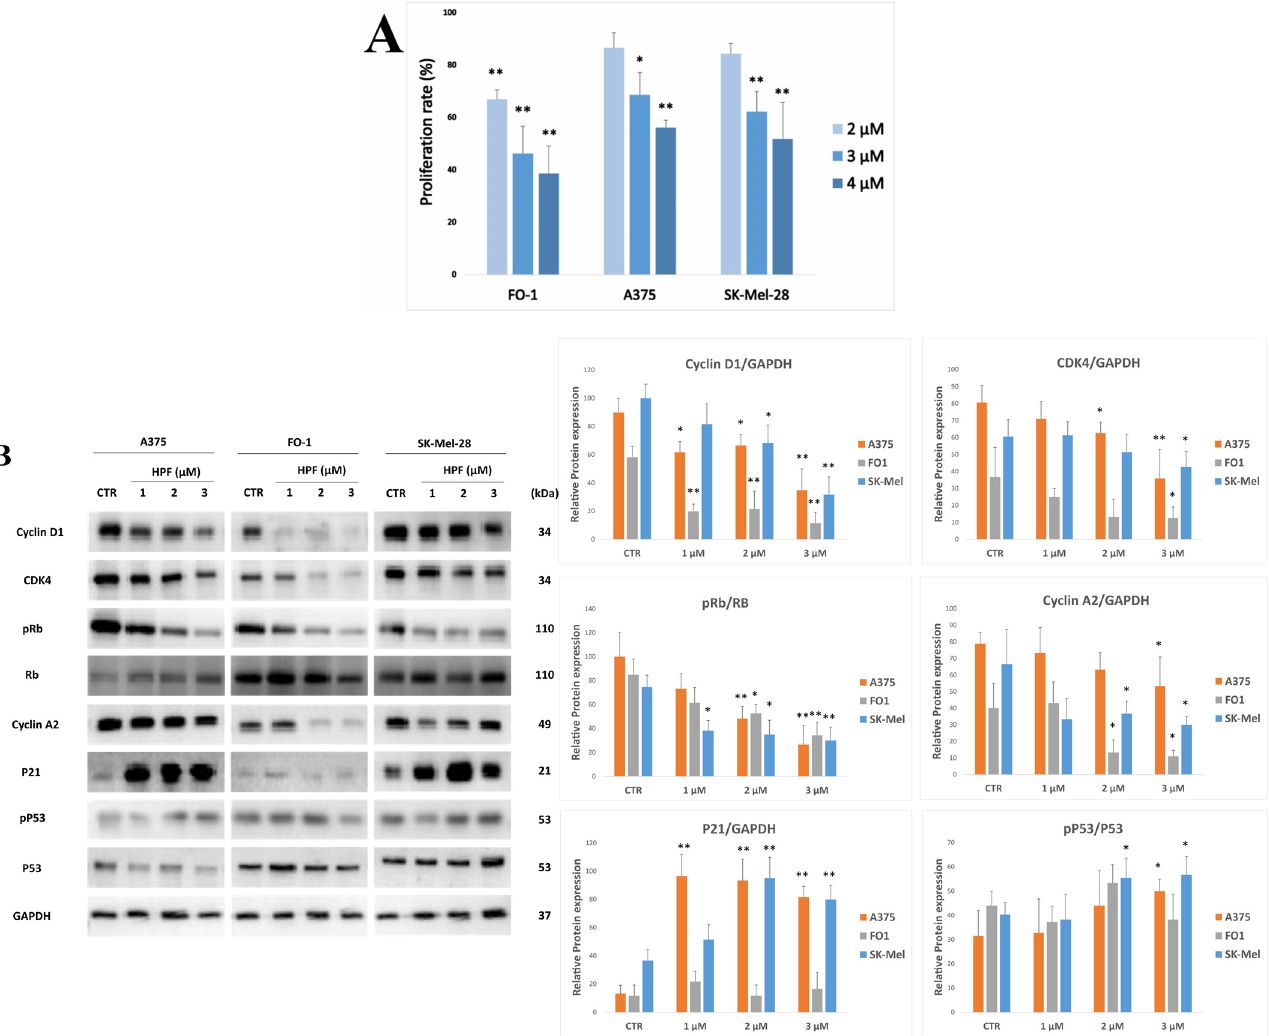
Figure 3. Hyperforin slows down melanoma cell proliferation by affecting the expression of several cell cycle-regulating proteins. ( A ) BrdU incorporation assay attesting the inhibition of cell proliferation of 2, 3 and 4 µM HPF on FO-1, A375 and SK-Mel-28 melanoma cell lines. ( B ) A375, FO-1 and SK-Mel-28 melanoma cells were treated with increasing concentrations of HPF for 24 h. In the left panel, representative immunoblots show the expression level of cyclin D1, cyclin-dependent kinase (CDK)-4, the phosphorylated form of retinoblastoma protein (pRb), total Rb protein, cyclin A2, P21/WAF1 (P21), phospho-Ser15-P53 (pP53), total P53 (P53) and glyceraldeide-3-phosphate dehydrogenase (GAPDH). On the right, histograms represent the mean values ± S.D. of protein expression level measured by densitometry deriving from three independent experiments and normalized with GAPDH expression, whereas pRb and pP53 results were normalized with total Rb and P53 protein level, respectively. All comparisons were performed vs. each control sample after data normalization; * p < 0.05; ** p < 0.01.